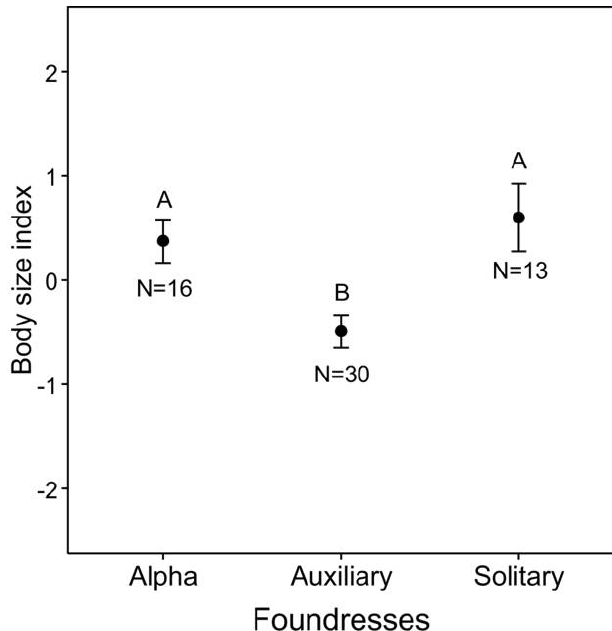
Fig 1. Variation in body size index (mean ± SD) for foundresses of Mischocyttarus consimilis . Different letters indicate statistical significance ( P <0.05).